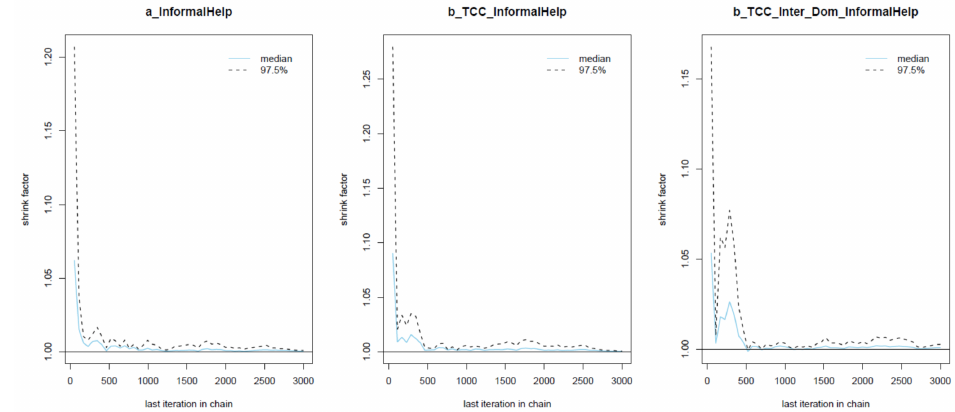
Figure A3. Gelman plots for Model 2 (cid:48) s posterior coefficients.